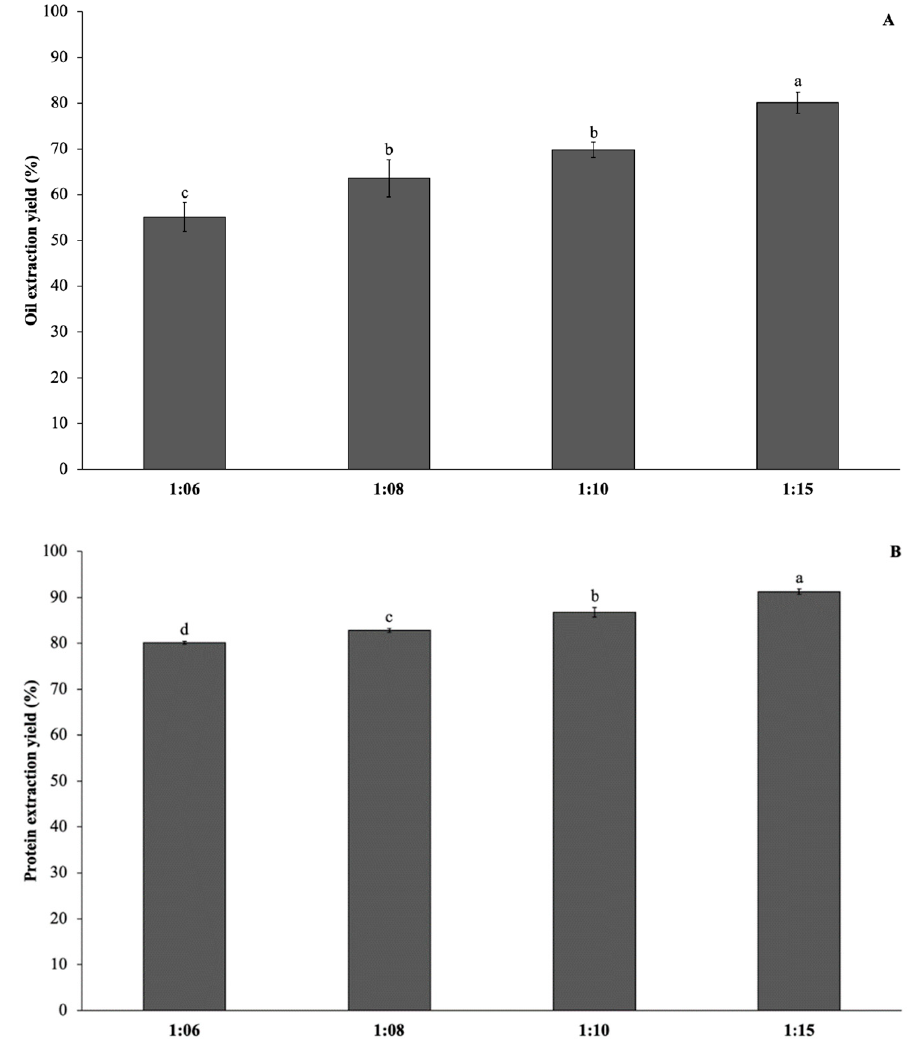
Figure 3. Total oil ( A ) and protein ( B ) extraction yields at different solids-to-liquid ratios (SLR). Different letters indicate statistically significant differences by one-way ANOVA followed by Tukey’s test at p < 0.05. Extractions were performed at pH 9.0, 0.5% of protease (w/w), 50 °C, 60 min.